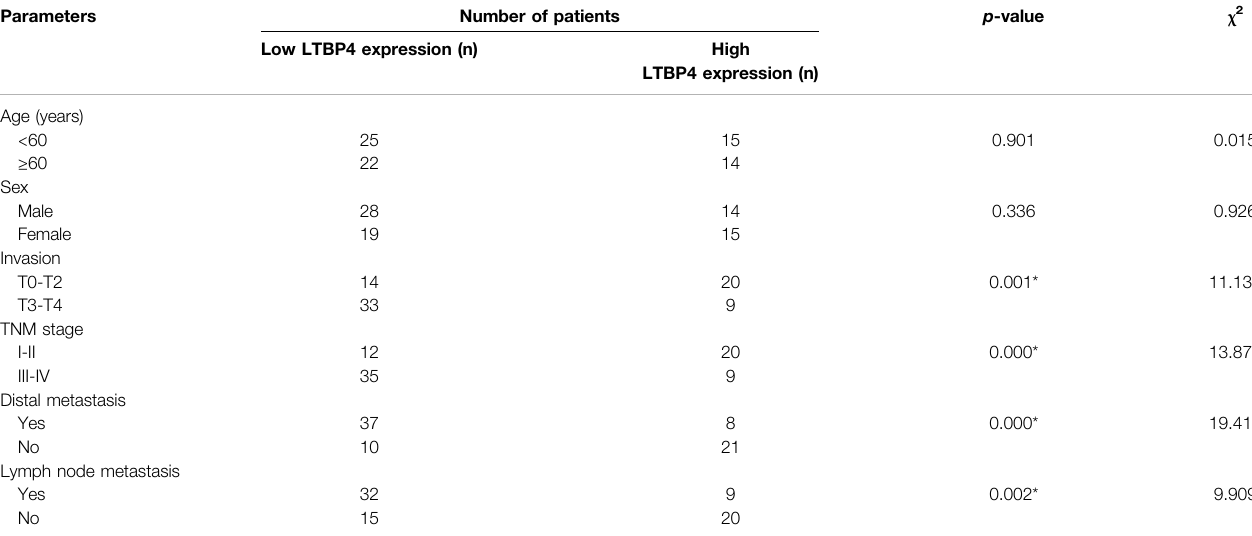
TABLE 1 | Correlation between LTBP4 expression and clinicopathological parameters of patients with melanoma.